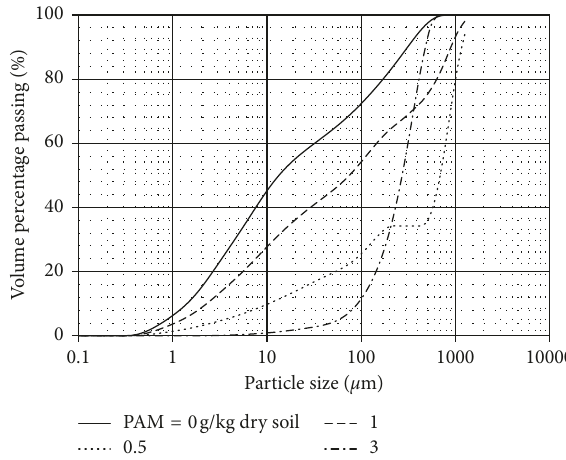
Figure 11: Particle size distributions of pure soil and flocculant- added soil (data from [4]).